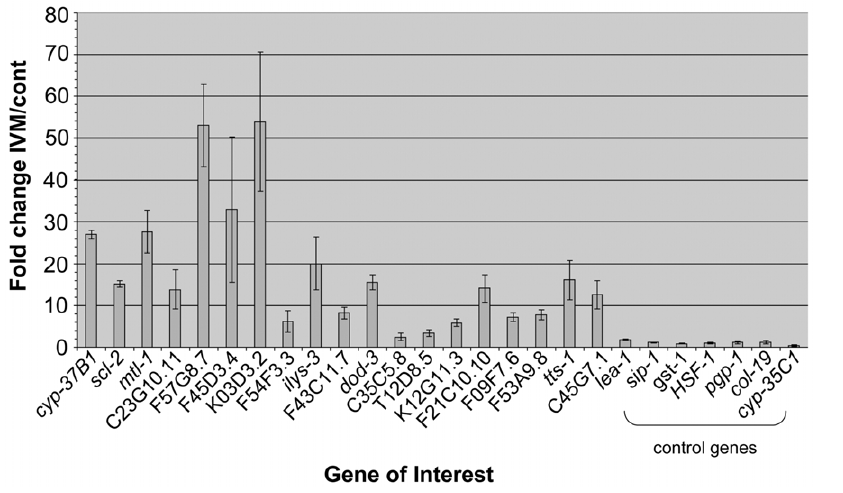
Figure 4. RTPCR assessment of gene expression following 4 hr exposure to IVM. Strain DA1316 was exposed to 1 m g/ml [1.1 m M] IVM (Virbamec) for 4 hr. Results are expressed as fold change relative to an unexposed control. Biological replicates were carried out in triplicate and the error bars represent the standard error. All genes proposed to be up-regulated by microarray were confirmed by RT-QPCR.